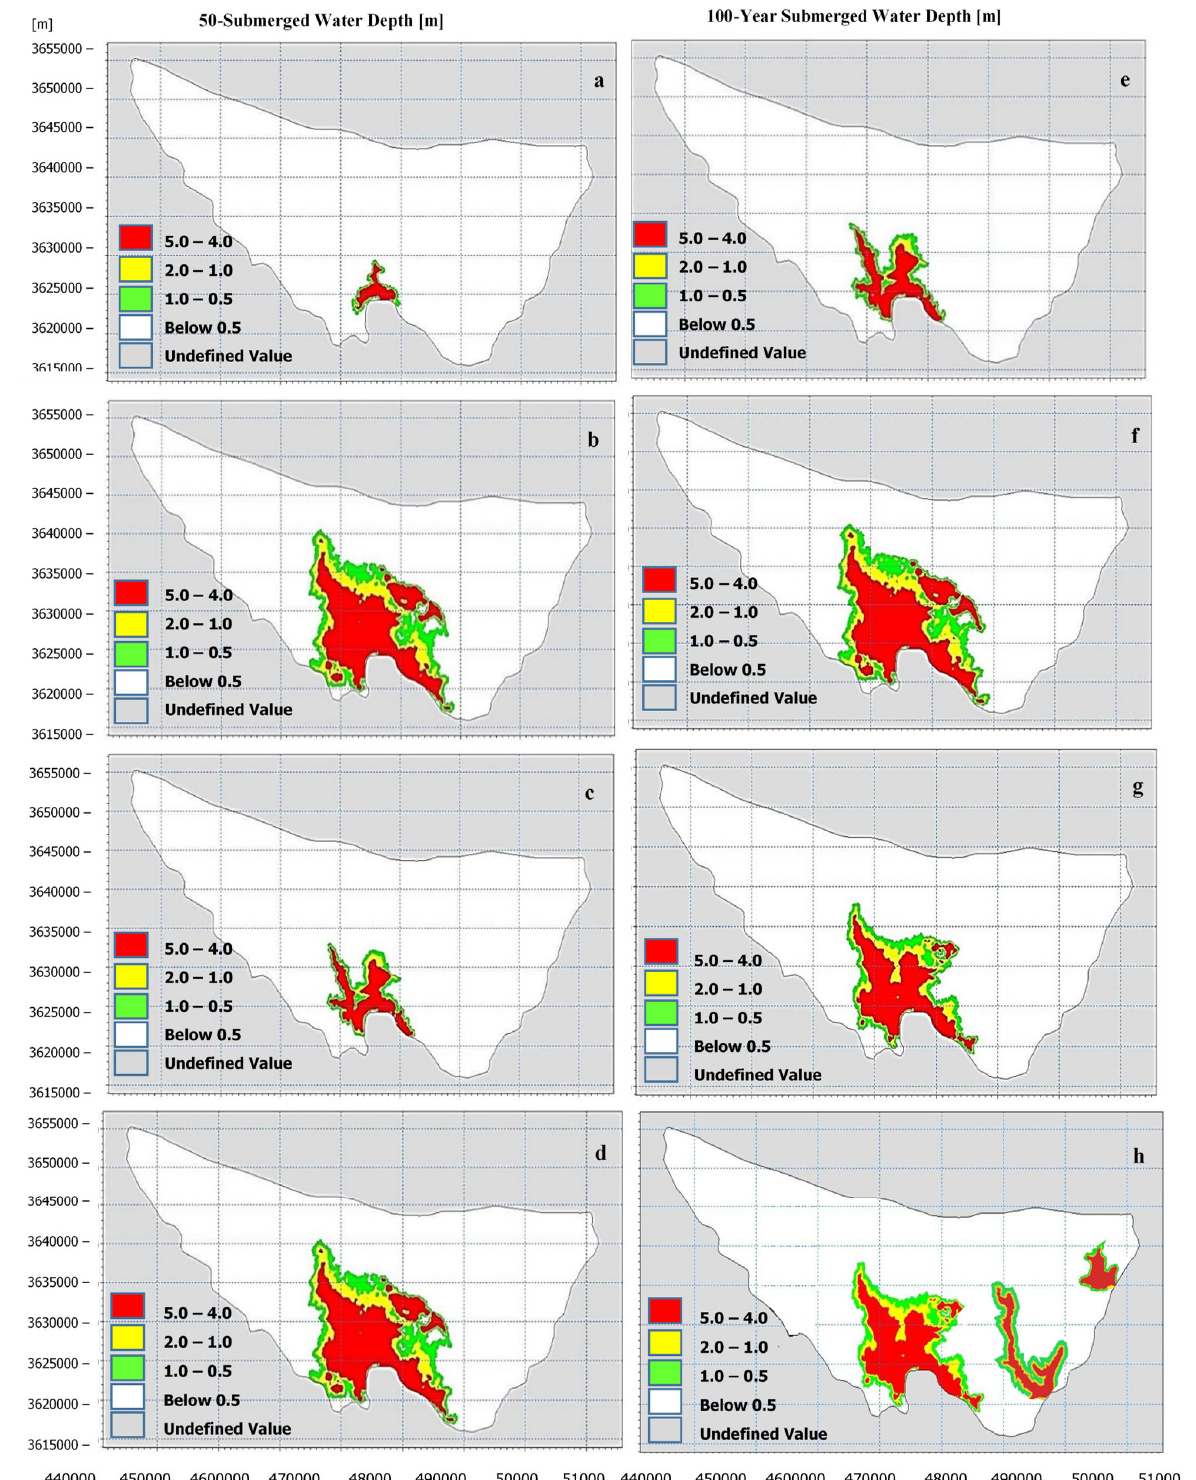
Figure 4. Flood inundation maps for 50 ‐ and 100 ‐ year flood events. The first four Figures ( a – d ) represent a 50 ‐ year flood, and ( e – h ) represent a 100 ‐ year flood with different time steps. Similarly, it was noted that in the 100 ‐ year flood inundation, the water flow entered the flood protection area at a comparatively higher rate than the 50 ‐ year flood with a lower time step. The inundation in the flood protection area of the Huaihe level increased due